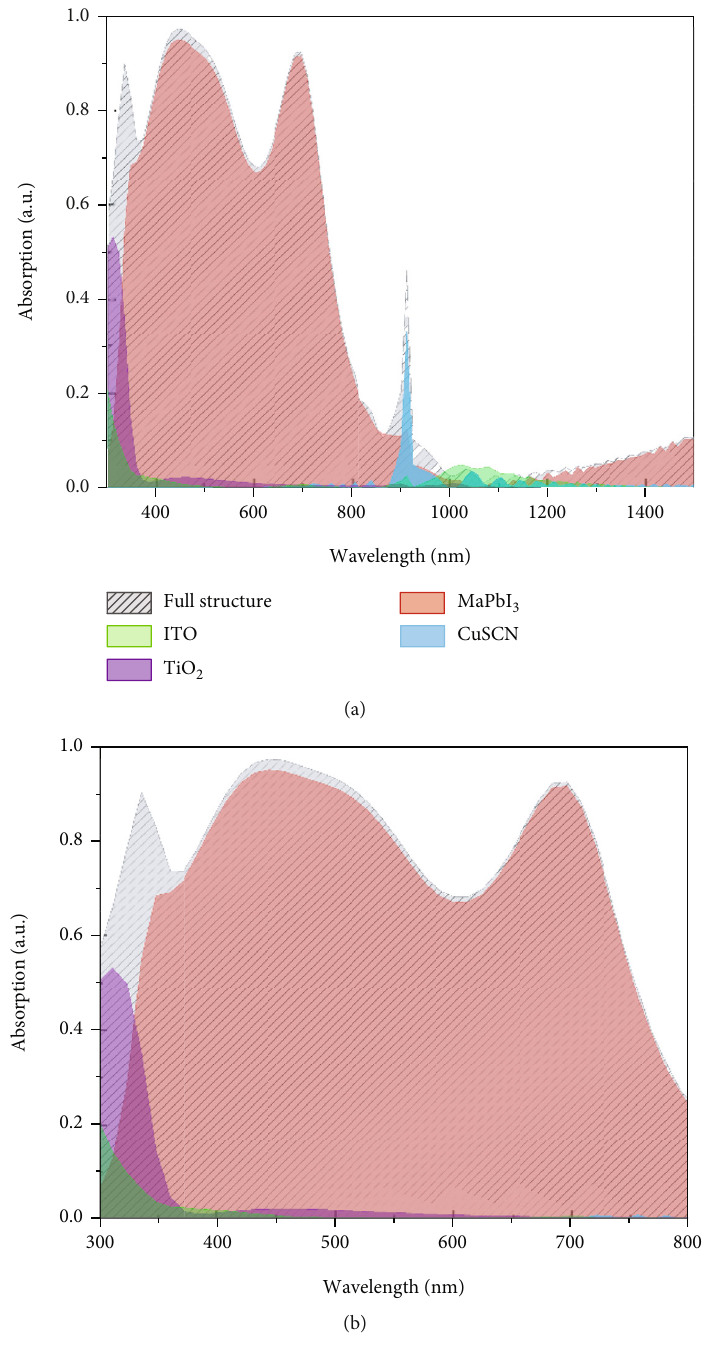
Figure 2: The spectral absorption of each layer in TiO